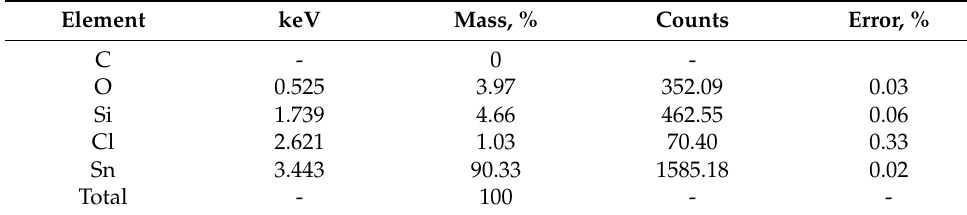
Figure 14. Elemental analysis of the film with no additives. Table 2. Elemental analysis of the